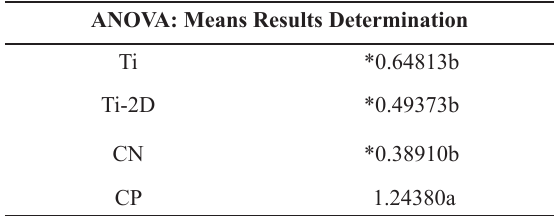
ANOVA statistical analyses for the samples subjected to the HDL test.